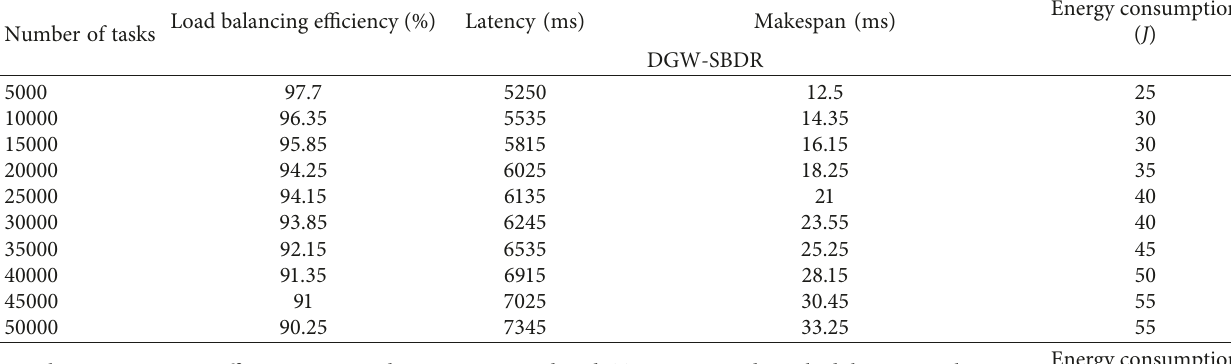
Table 7: Summary of results